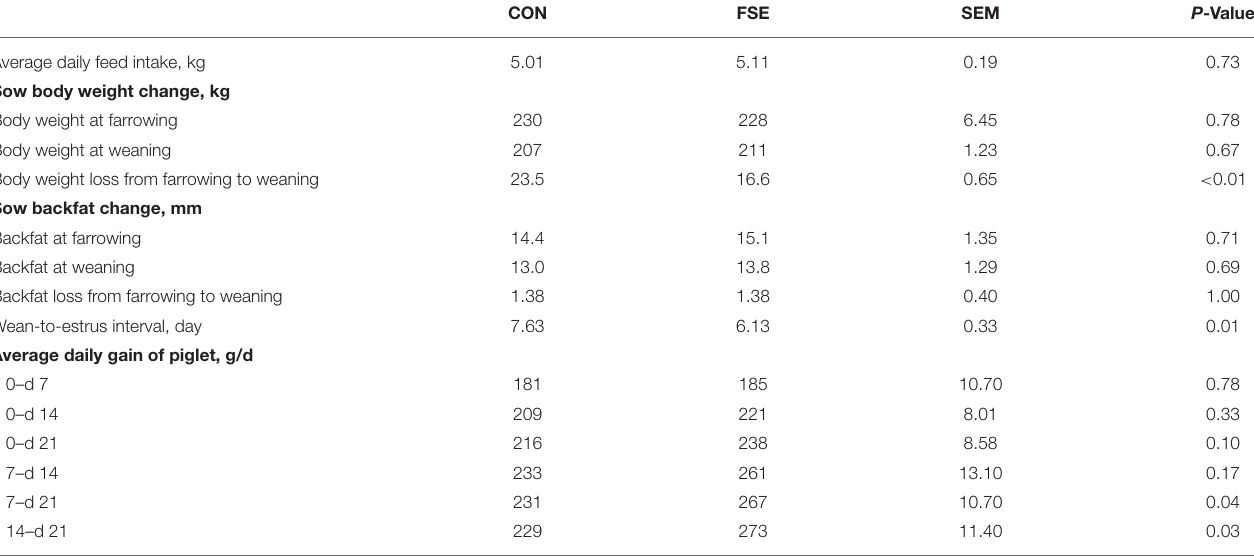
TABLE 2 | Effects of Forsythia suspensa extract on reproductive performance of sows. CON FSE SEM P -Value Average daily feed intake, kg